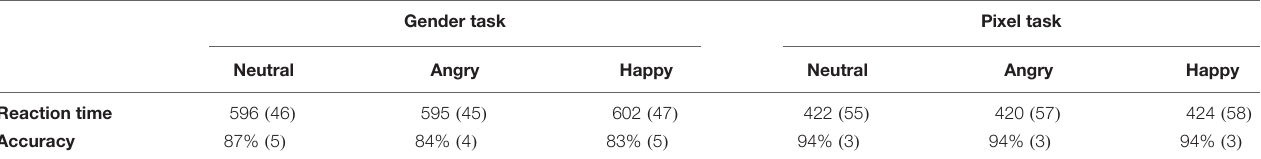
TABLE 1 | Behavioral